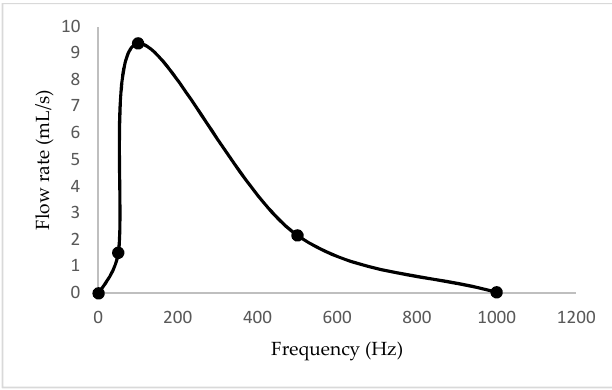
Figure 5. Volumetric plot of velocity profile.